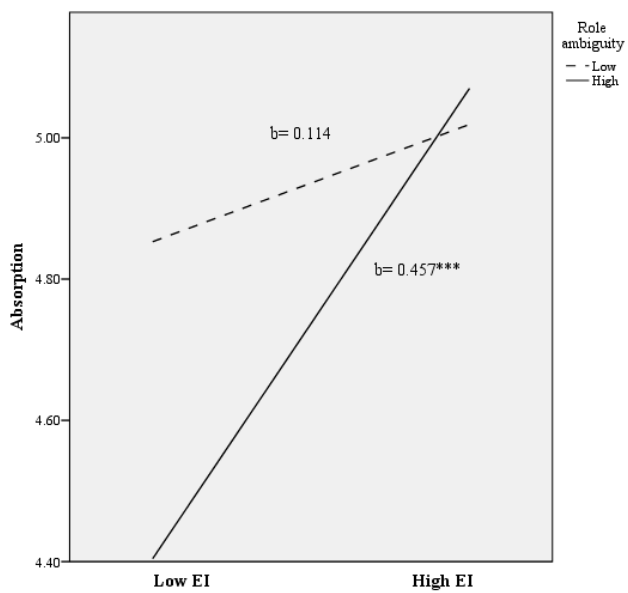
Figure 3. The relationship of emotional intelligence and role ambiguity for predicting absorption scores. Note: EI = Emotional Intelligence. *** p < 0.001. Int. J. Environ. Res. Public Health 2017 , 14 , 1156